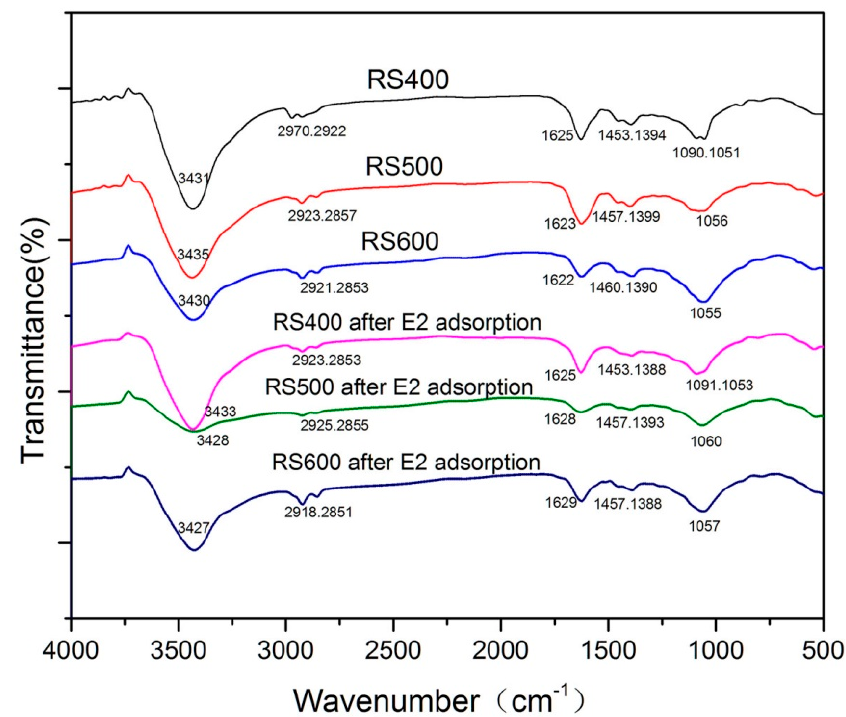
Figure 1. FTIR spectra of BCs and BCs after E2 adsorption.